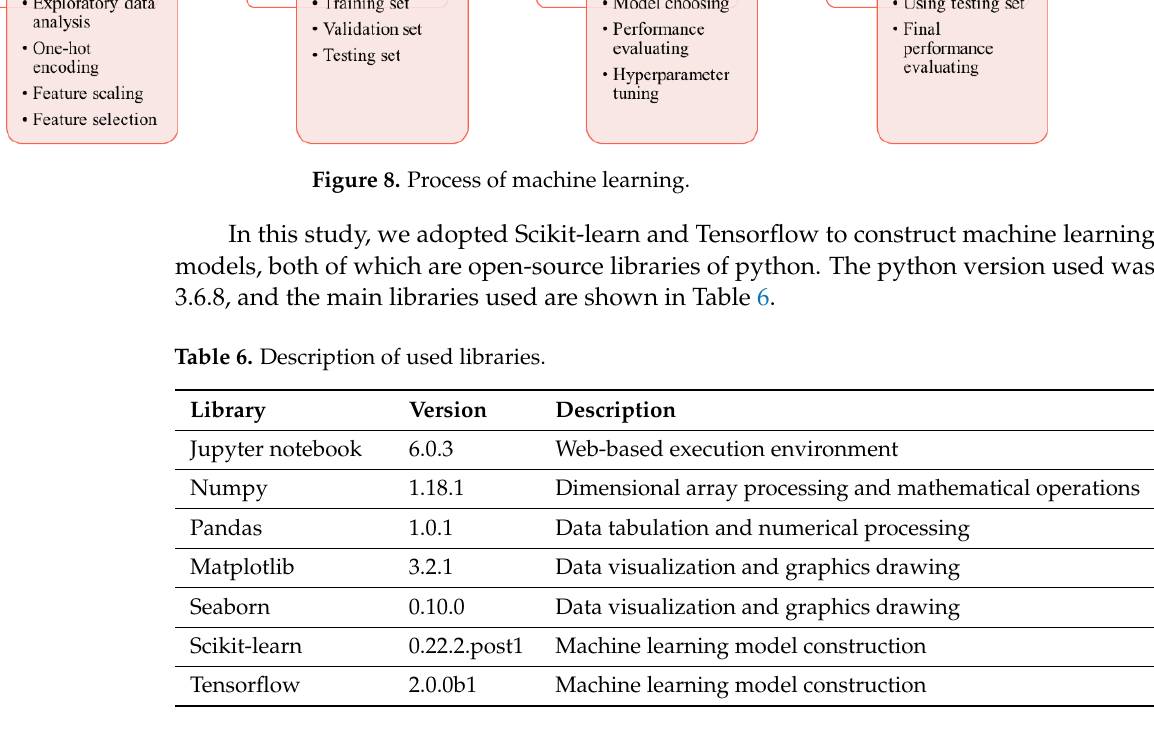
Table 5. Material setting of wall.